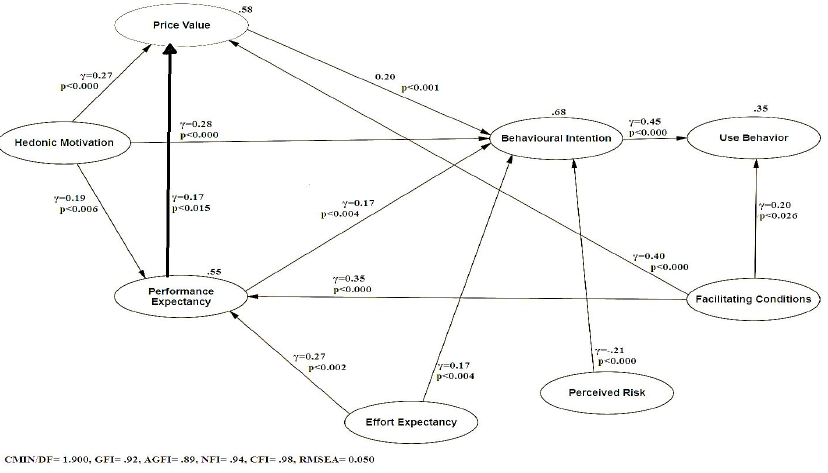
Fig. 2. Internet Banking SEM